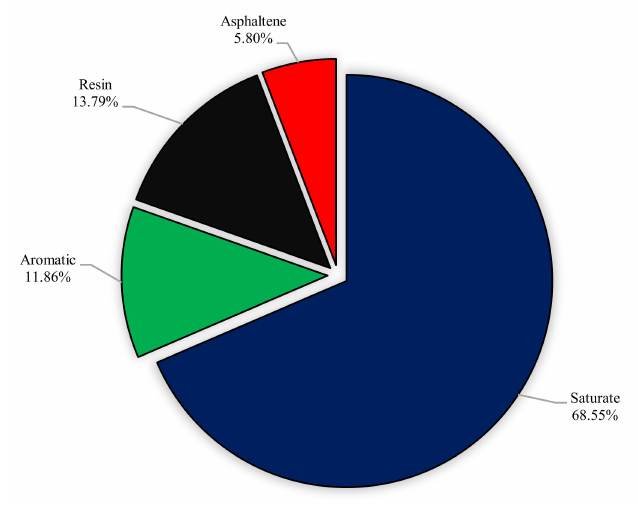
Figure 3. The results of SARA analysis for used crude oil.